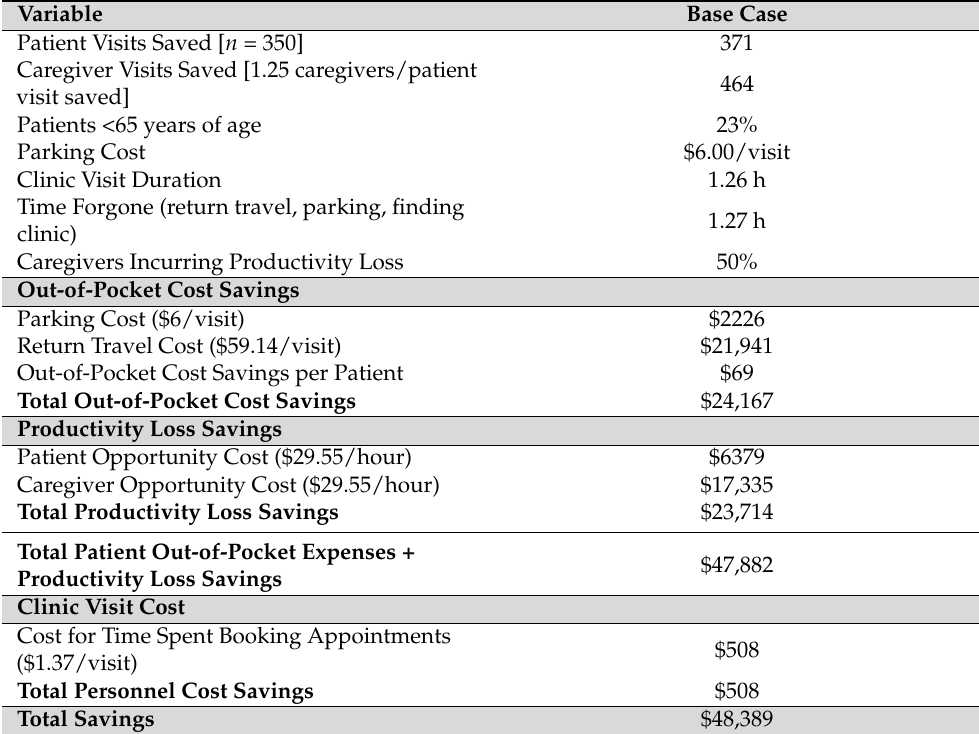
Table 3. Economic benefits of MDC versus traditional model of